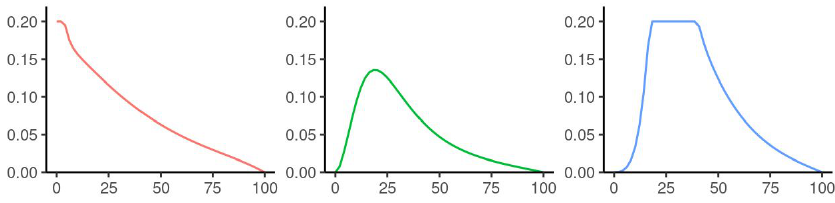
Figure 13. Experiment 2. The structure of the optimal treatment policies u i ( t ) , i = 1,2,3. Aggregate changes in all fractions of the population are shown in Figure 14. The ag- gregated system cost in the uncontrolled case is 29.43 million euros compared with 14.07 million euros in the controlled case (Figure 15).